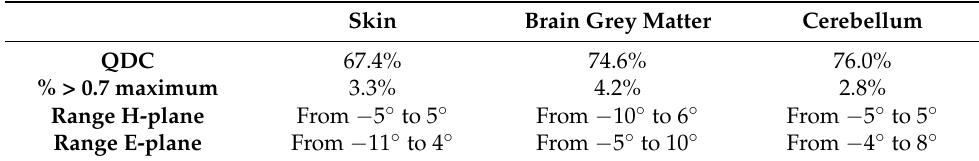
Table 3. The QDC values, the percentage of SAR 10 g higher than the 70% of the maximum values and the variation range extremes of the two input parameters for the skin, for the brain grey matter and for the cerebellum. Skin Brain Grey Matter % > 0.7 maximum Range H-plane From − 5 ◦ to 5 ◦ From − 10 ◦ to 6 ◦ From − 5 ◦ to 5 ◦ Range E-plane From − 11 ◦ to 4 ◦ From − 5 ◦ to 10 ◦ From − 4 ◦ to 8